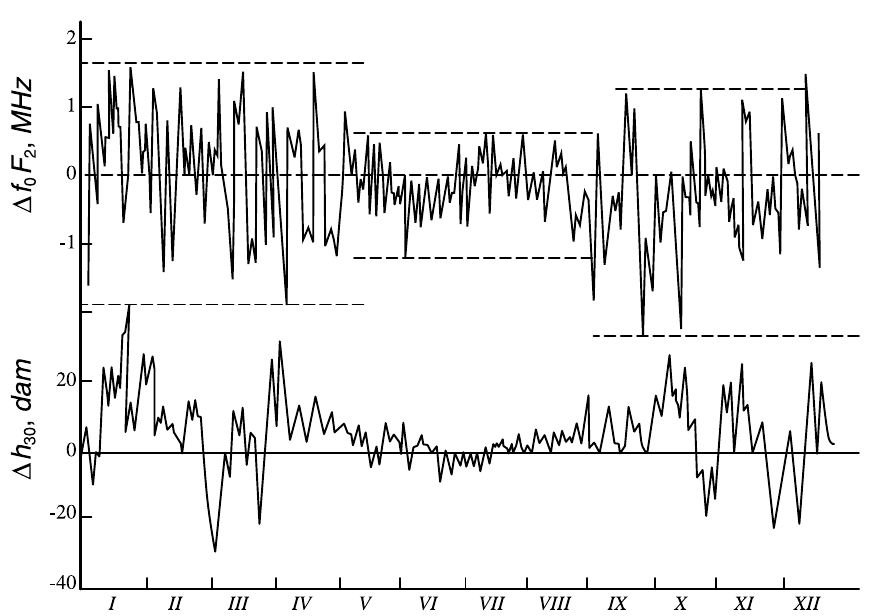
Fig. 11. Stratospheric effects on the ionospheric F -region. Daily values of the difference in noon values of f Mountains), located almost at 55 ° N. I, II, III...XII - months, 1969 (Kazimirovsky and Kokourov, 1991)